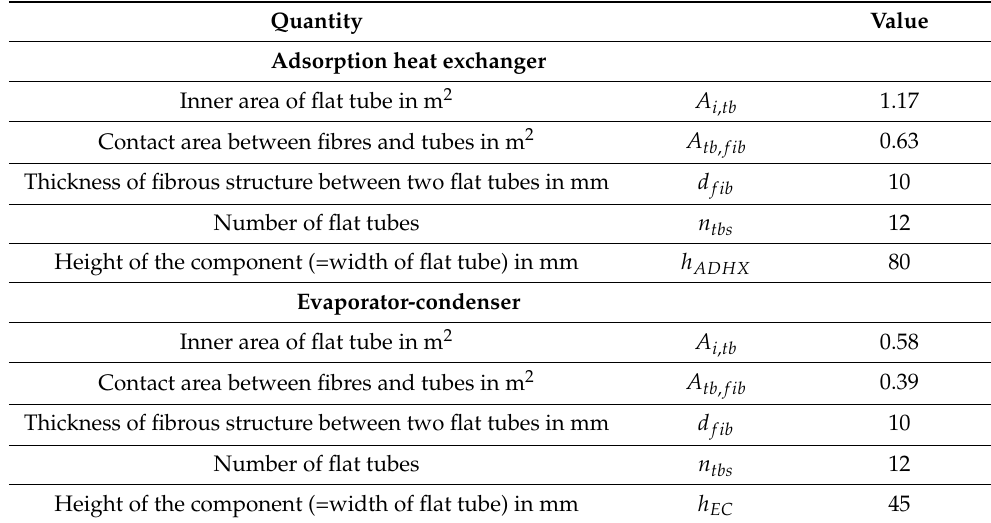
Table 2. Additional geometric data of ‘Size S’